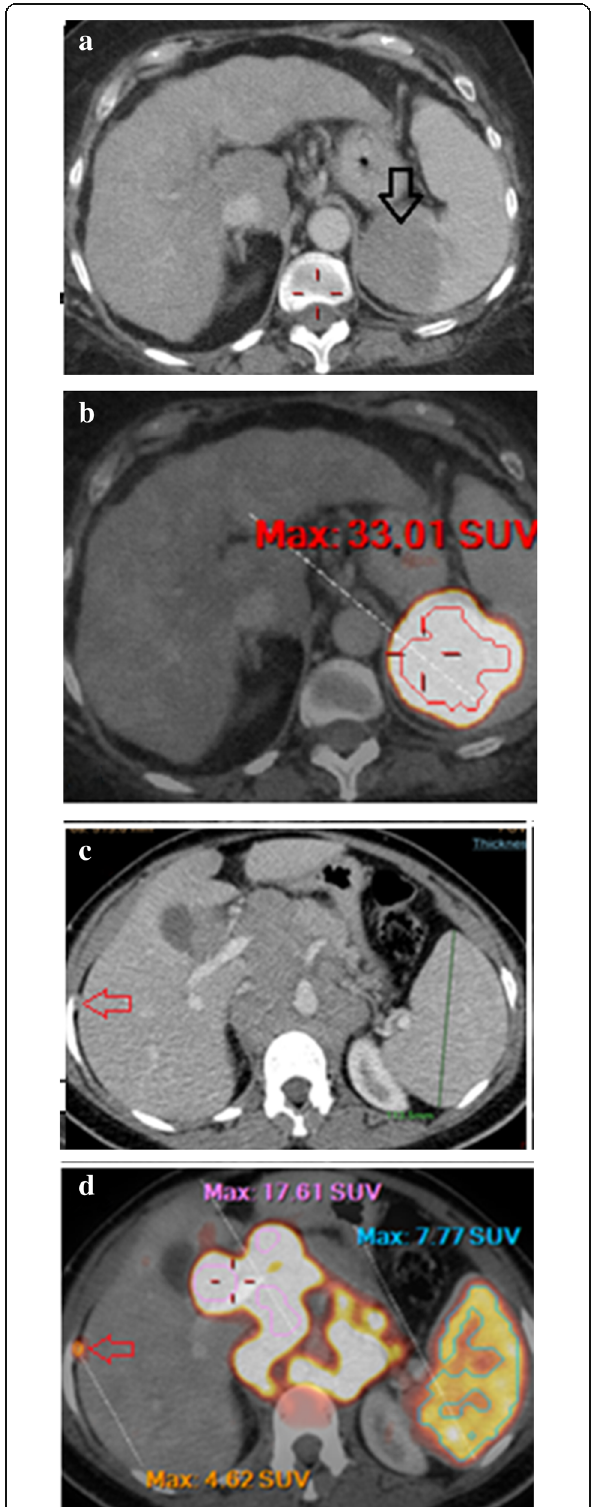
Fig. 2 Two different cases. a , b Focal splenic infiltration (black arrow). c , d Diffuse splenic infiltration in a patient with B cell lymphoma with normal size and attenuation of the spleen ( c ). Associated multiple retroperitoneal avid lymph nodes and a peri- hepatic peritoneal nodule (red